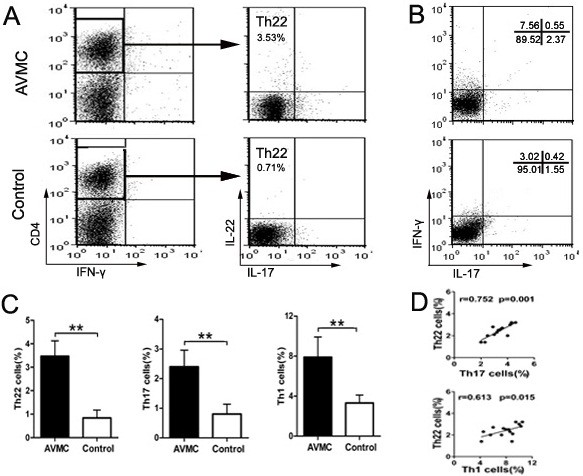
Increased proportions of Th22, Th17 and Th1 cells in AVMC were investigated by flow cytometry analysis, on day 14 post injection.A.Th22 cells within CD4+T cells were identified based on their expressions of IL-22+IL-17-IFN-γ-CD4+. B.Th17 and Th1 cells within CD4+T cells were determined based on their expressions of IL17+CD4+ and IFN-γ+CD4+. C. Comparisons of Th22, Th17 and Th1 cells in AVMC and control groups. D. The correlation analysis of Th22 and Th17, Th22 and Th1 cells in AVMC group. Each point represented an individual mouse. **p < 0.01. Data are mean ± SD.